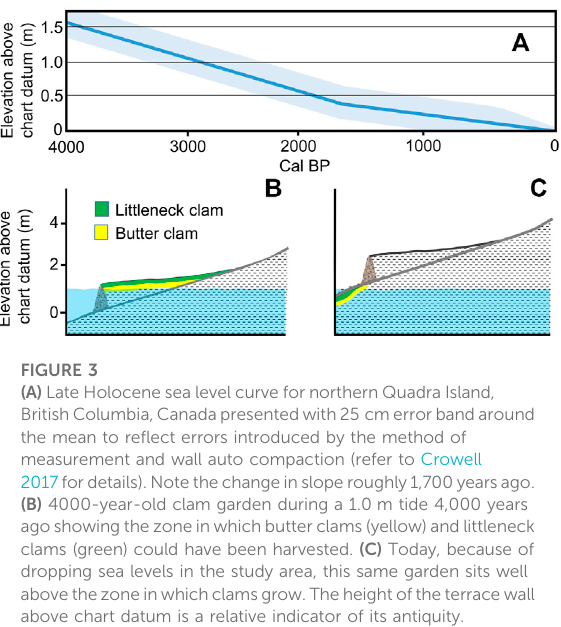
FIGURE 3 (A) Late Holocene sea level curve for northern Quadra Island, BritishColumbia,Canadapresentedwith25 cmerrorbandaround the mean to re fl ect errors introduced by the method of measurement and wall auto compaction (refer to Crowell 2017fordetails).Notethechangeinsloperoughly1,700yearsago. (B) 4000-year-old clam garden during a 1.0 m tide 4,000 years agoshowingthezoneinwhichbutterclams(yellow)andlittleneck clams (green) could have been harvested. (C) Today, because of dropping sea levels in the study area, this same garden sits well abovethezoneinwhichclamsgrow.Theheightoftheterracewall above chart datum is a relative indicator of its